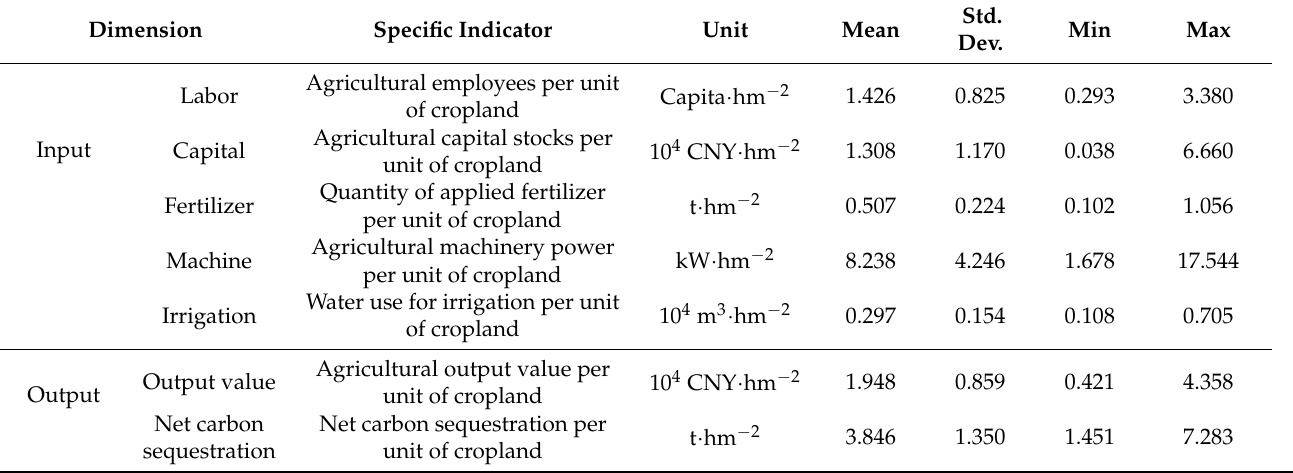
Table 2. Statistical description of the input and output indicators of cropland use systems in Chinese principal grain- producing provinces from 2000 to